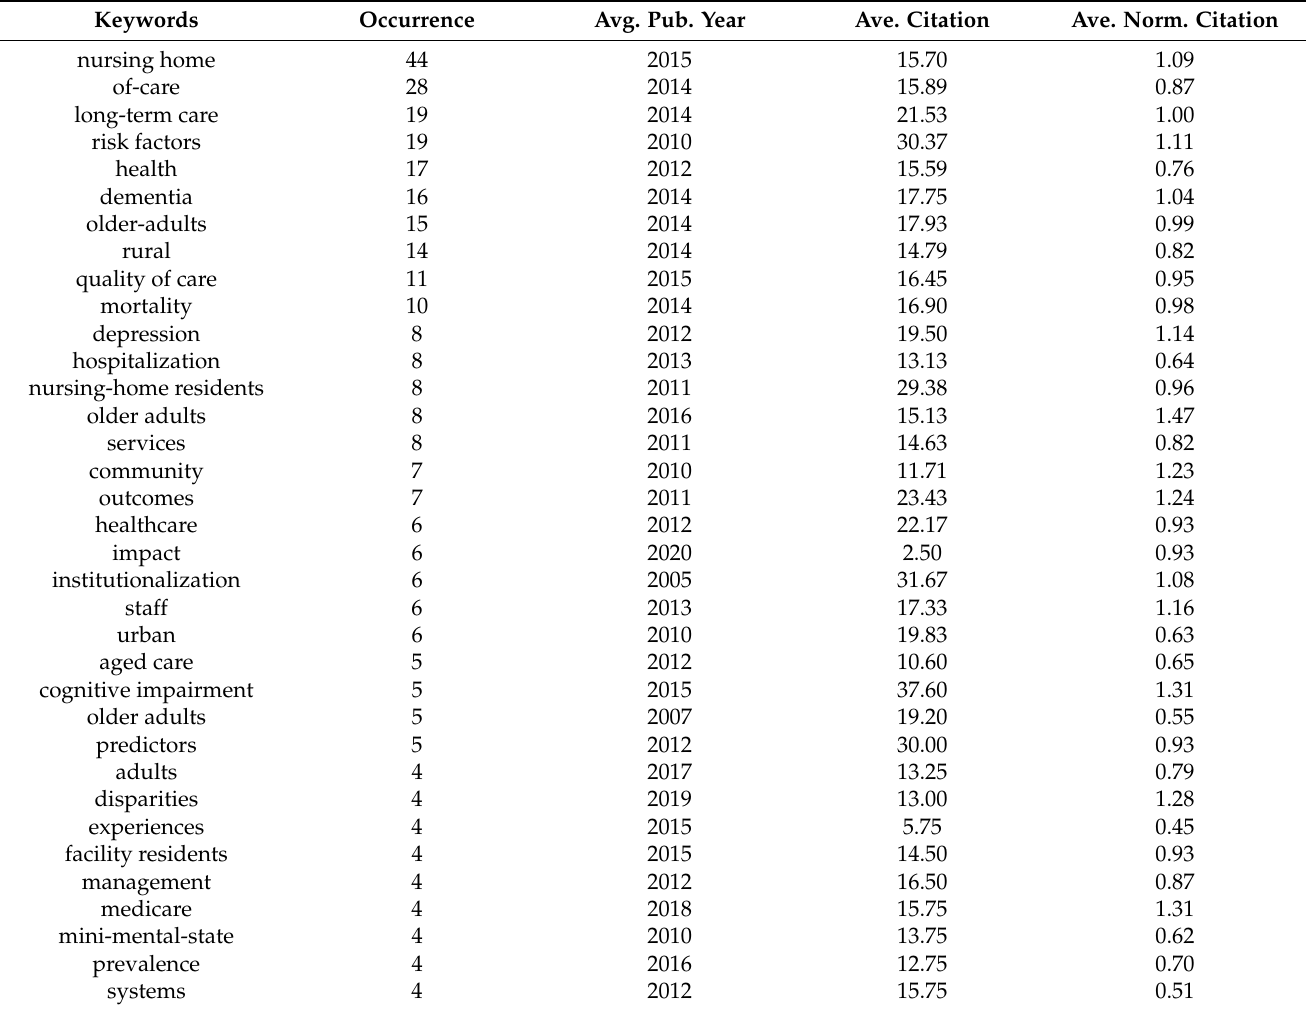
Table 4. Summaries of main keywords in the rural institutional elder care